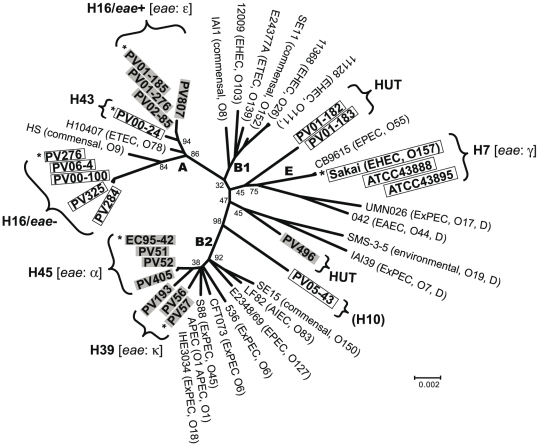
Correlation between evolutionary lineages and distribution of two types of rfbE genes among O157:H7/non-H7 stains.21 fully sequenced E coli strains were used as references. The phylogenetic tree was constructed based on concatenated sequences of seven housekeeping genes. E. coli phylogroups (A, B1, B2, D and E) were determined by comparing with sequences from the ECOR collection. O157:H7/non-H7 strains carrying “Sakai-type rfbE” and “PV01-185-type rfbE” are indicated by clear and gray boxes, respectively. Six O157 strains indicated by asterisks were used for the sequence comparisons of O157-antigen gene clusters and their flanking regions.